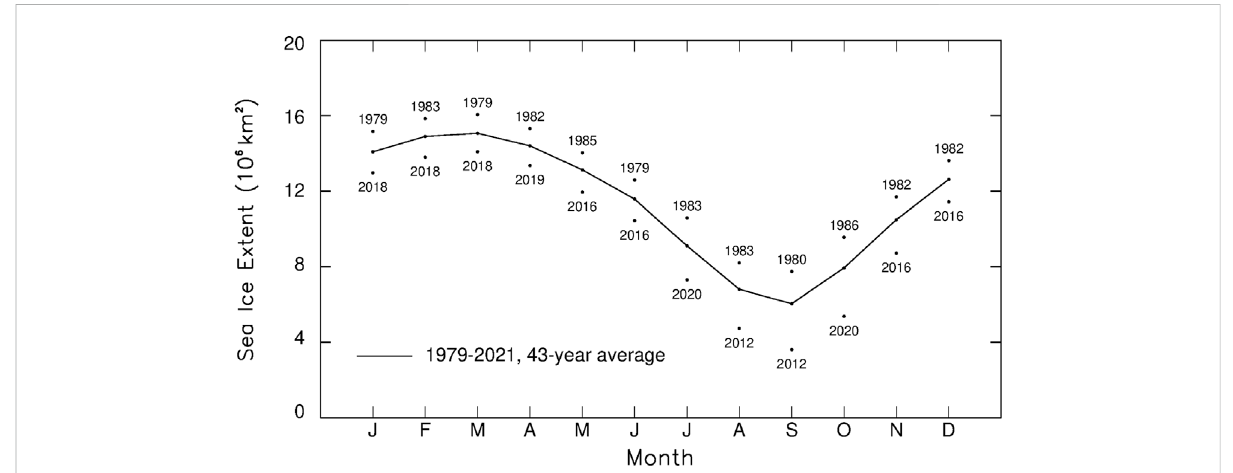
FIGURE 5 Average annual cycleofmonthly-average Arctic sea iceextents overthe43-year period1979 – 2021,alongwith the43-year highestandlowest monthly-average values for each month and the years in which those highs and lows occurred.